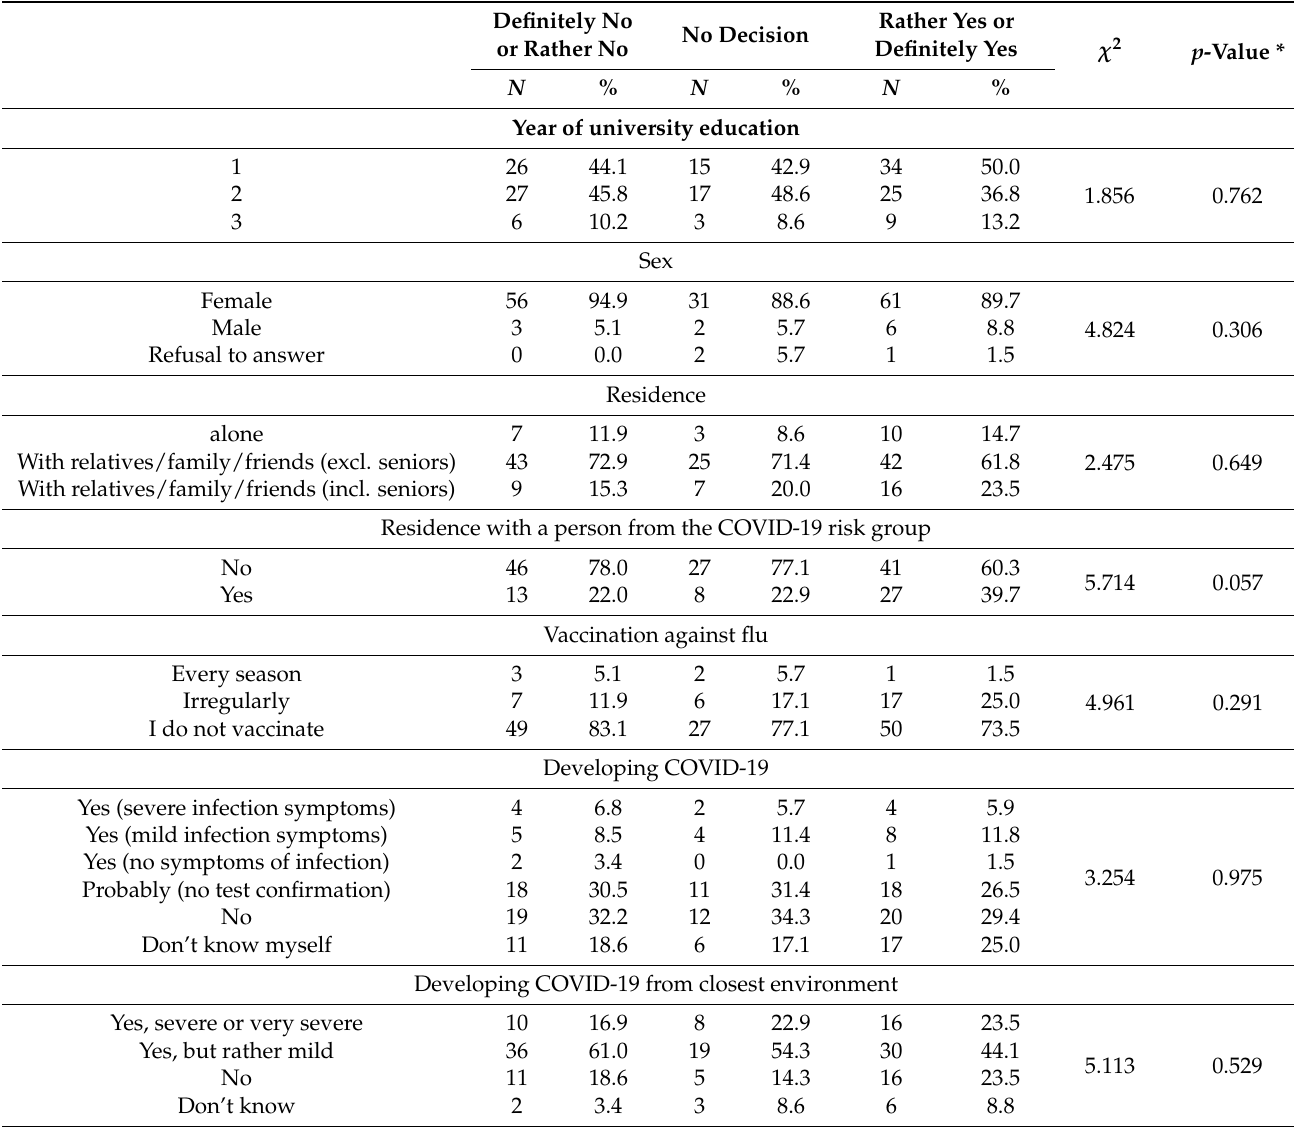
Table 3. Analysis of the potential factors that could influence the decision for or against